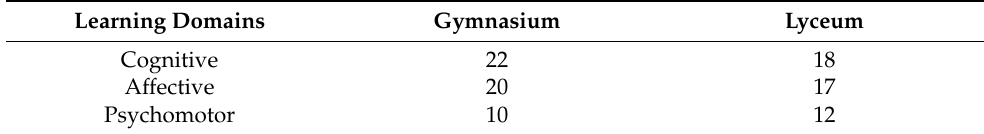
Table 5. Taxonomy of the expected learning outcomes in learning